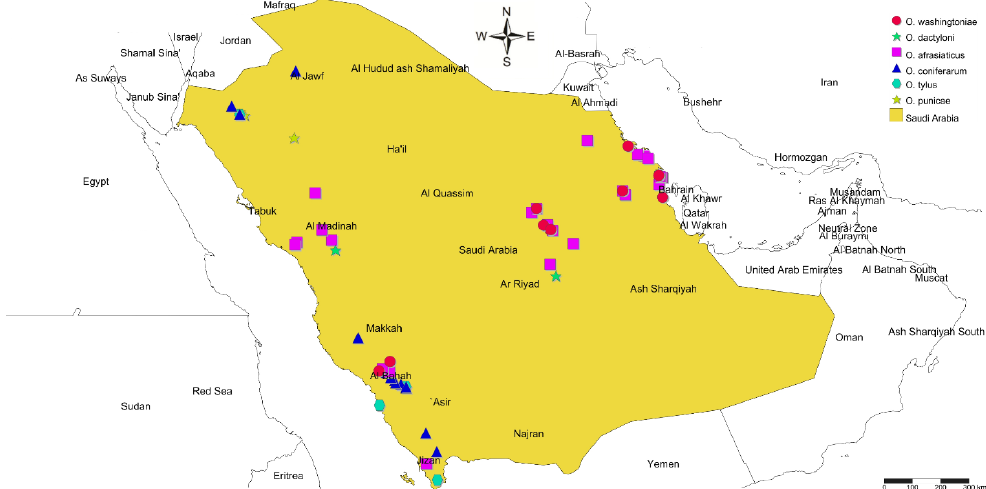
Figure 2. Geographical distribution of 61 spider mite samples of Oligonychus afrasiaticus , O. conifer- arum , O. dactyloni , O. punicae , O. tylus , and O. washingtoniae , reported from various hosts and localities of 10 provinces in Saudi Arabia.